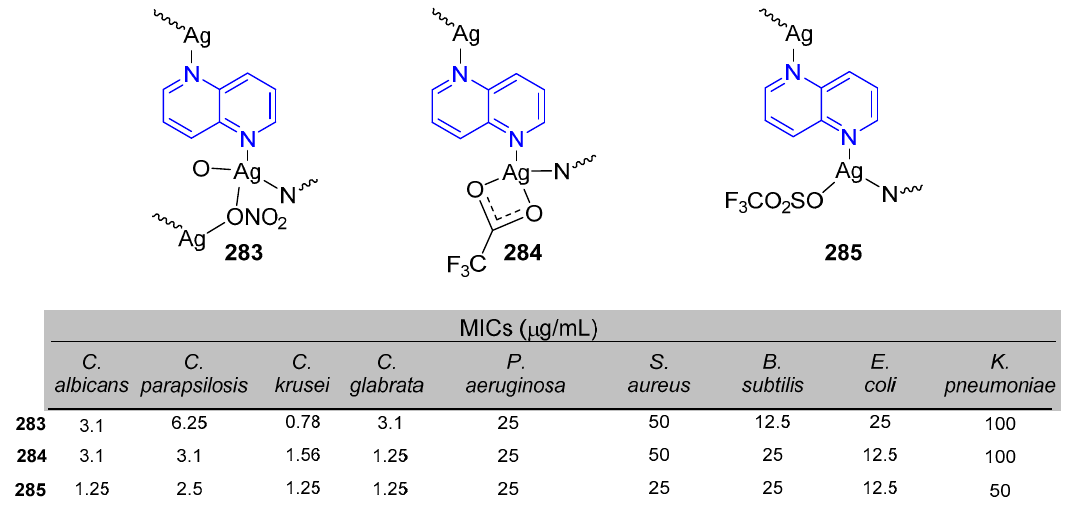
Figure 16. Antibacterial activity of silver complexes.